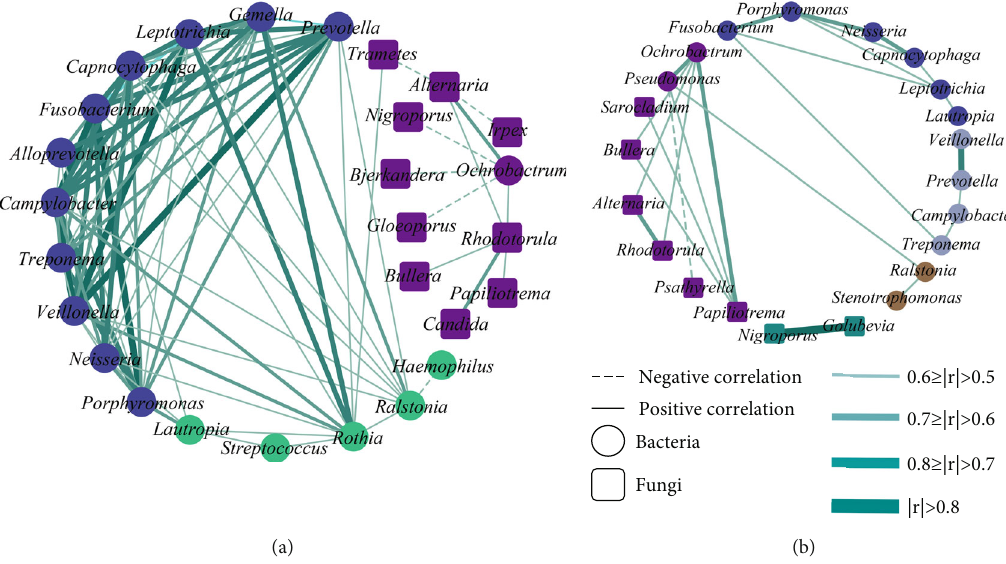
Figure 6: Fungal-bacterial correlation network analysis at genus level in (a) COPD and (b) asthma. Each microbial taxon represented by a node, the round nodes represent the genus of bacteria, the square nodes represent the genus of fungi. The network represents signi fi cant Spearman ’ s correlation coe ffi cients between the top 20 fungal and bacterial genera (FDR-corrected P < 0 : 01 , ∣ r ∣ >0 : 5 ). The solid line indicated positive correlation, the dashed line indicated negative correlation, and the strength of correlation between genera was indicated by the dark and light colors and the thickness of the lines. The color of the nodes represented the di ff erent